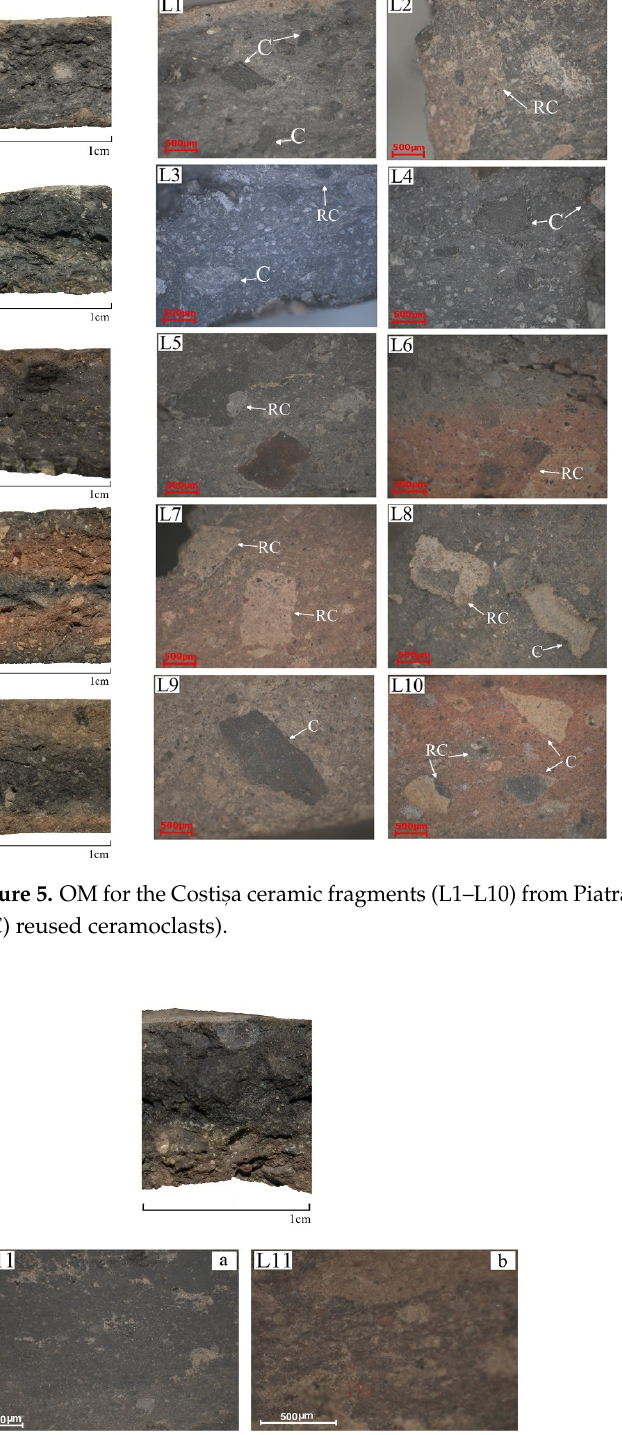
Figure 6. OM for the L11 sample ( a , b ) core; ( c , d ) inner surface with residues. Reused ceramoclasts identified by optical microscopy indicate a concern for reusing damaged vessels and their “recycling” as inclusions of the new ones. The organic matter visible in most of the ceramic fragments could indicate the firing temperatures, which did not reach high values. The minerals identified microscopically were quartz, mica and iron oxides, which were part of the raw material clay used to manufacture pottery from Piatra Neam ț – Lut ă rie . 3.2.2. SEM-EDX Analyses The SEM-EDX analyses were performed both on the core and on the surfaces, keep- ing the notations from the OM analyses. The SEM micrographs for the core of the Costi ș a samples (Figures 7 and 8) show a good homogeneity of the microstructural elements, which are well incorporated in the clay matrix (L1, L4). A compact lamellar structure was also visible (L8). In most samples (L2, L3, L5, L6, L7, L9, L10), individualized mineral particles are visible, with a low homogeneity, and in other samples, traces of vegetal fibers were no- ticed (L7, L10), aspects that suggest relatively low firing temperatures. The SEM images also show elongated and flattened pores, present in five samples (L1, L5, L8, L9, L10), which indicate using the coiling technique in making the vessels [29].